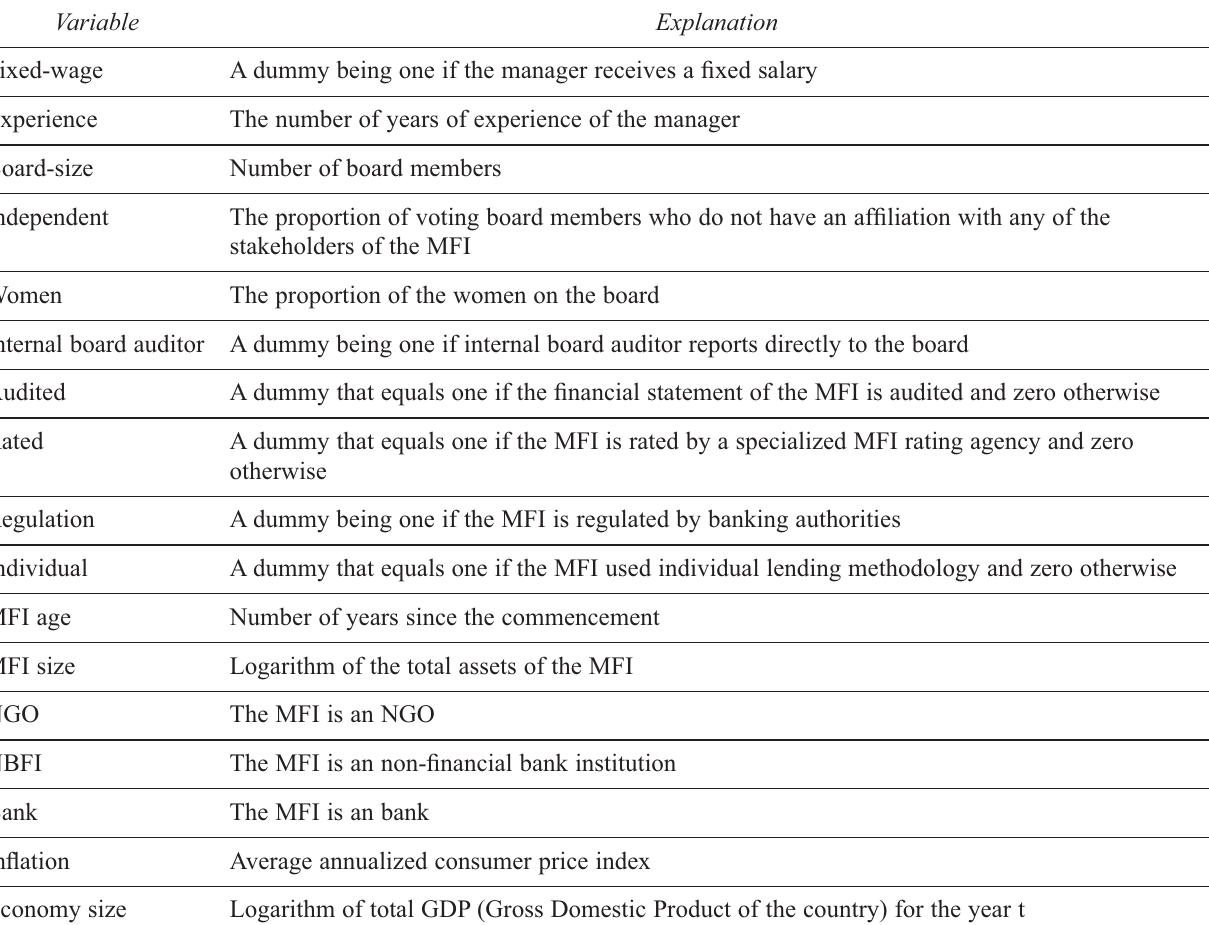
Table 2. Defi nitions of independent variables used in